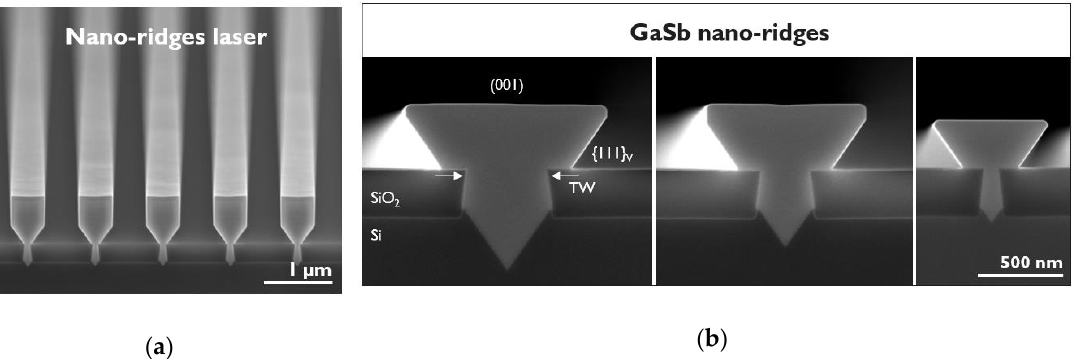
Figure 2. ( a ) Tilted cross-section scanning electron microscope (SEM) image of a nano-ridge laser array based on GaAs. ( b ) Cross-section SEM image of GaSb nano-ridges grown on top of a 500 nm, 300 nm and 80 nm wide trench. The white arrows indicate the location to define the trench width (TW). For the chosen growth conditions the NR profile is like a funnel and defined by large (001) and {111} V facets.